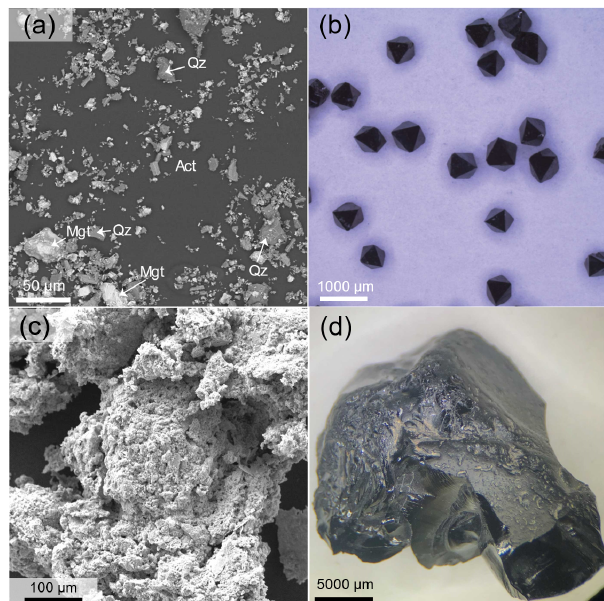
Figure 1. Images of the studied samples before the grinding. (a) BSE image of IF-G; (b) photograph of magnetite crystals from Rocher Blanc (Alps, France); (c) BSE image of nano-magnetite par- ticles (NMA sample); and (d) photograph of the fragment of Al-Spl macrocrystal used for this